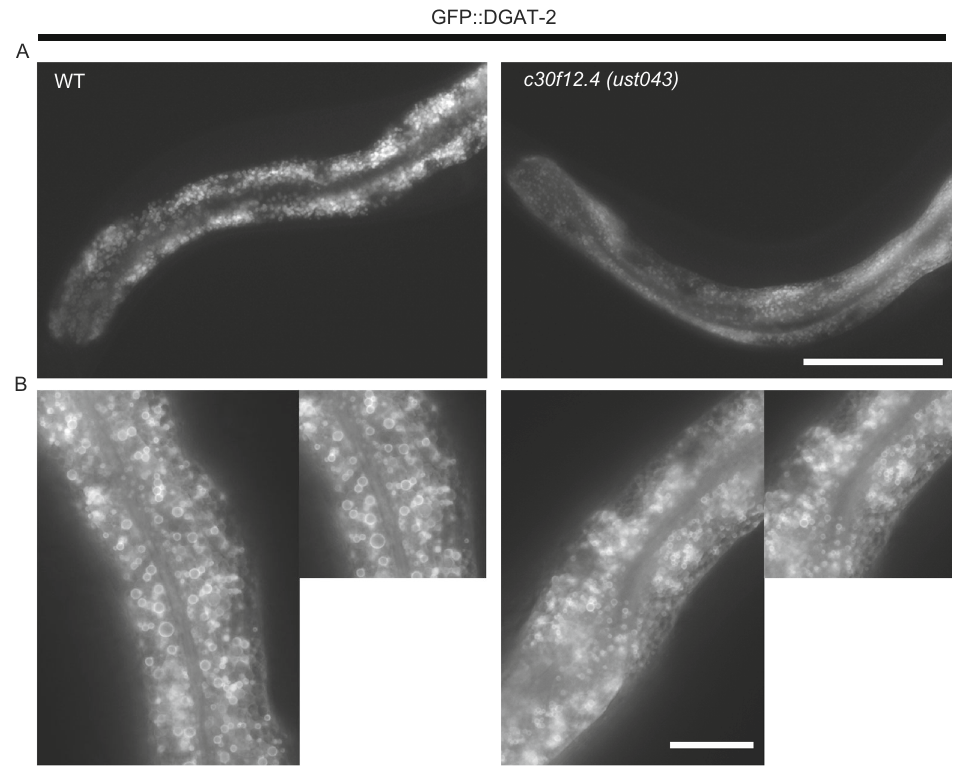
Figure 5. Loss of c30f12 .4 altered fat storage in hjSi56 worms. L4 stage wild-type and c30f12.4 mutant worms on an hjSi56 background were detected directly. Images were captured using identical settings and exposure time for each image. Loss of c30f12.4 led to decreased fat storage (A) and smaller lipid droplets (B). Scale bar = 20 μ m (A) and 50 μ m (B).